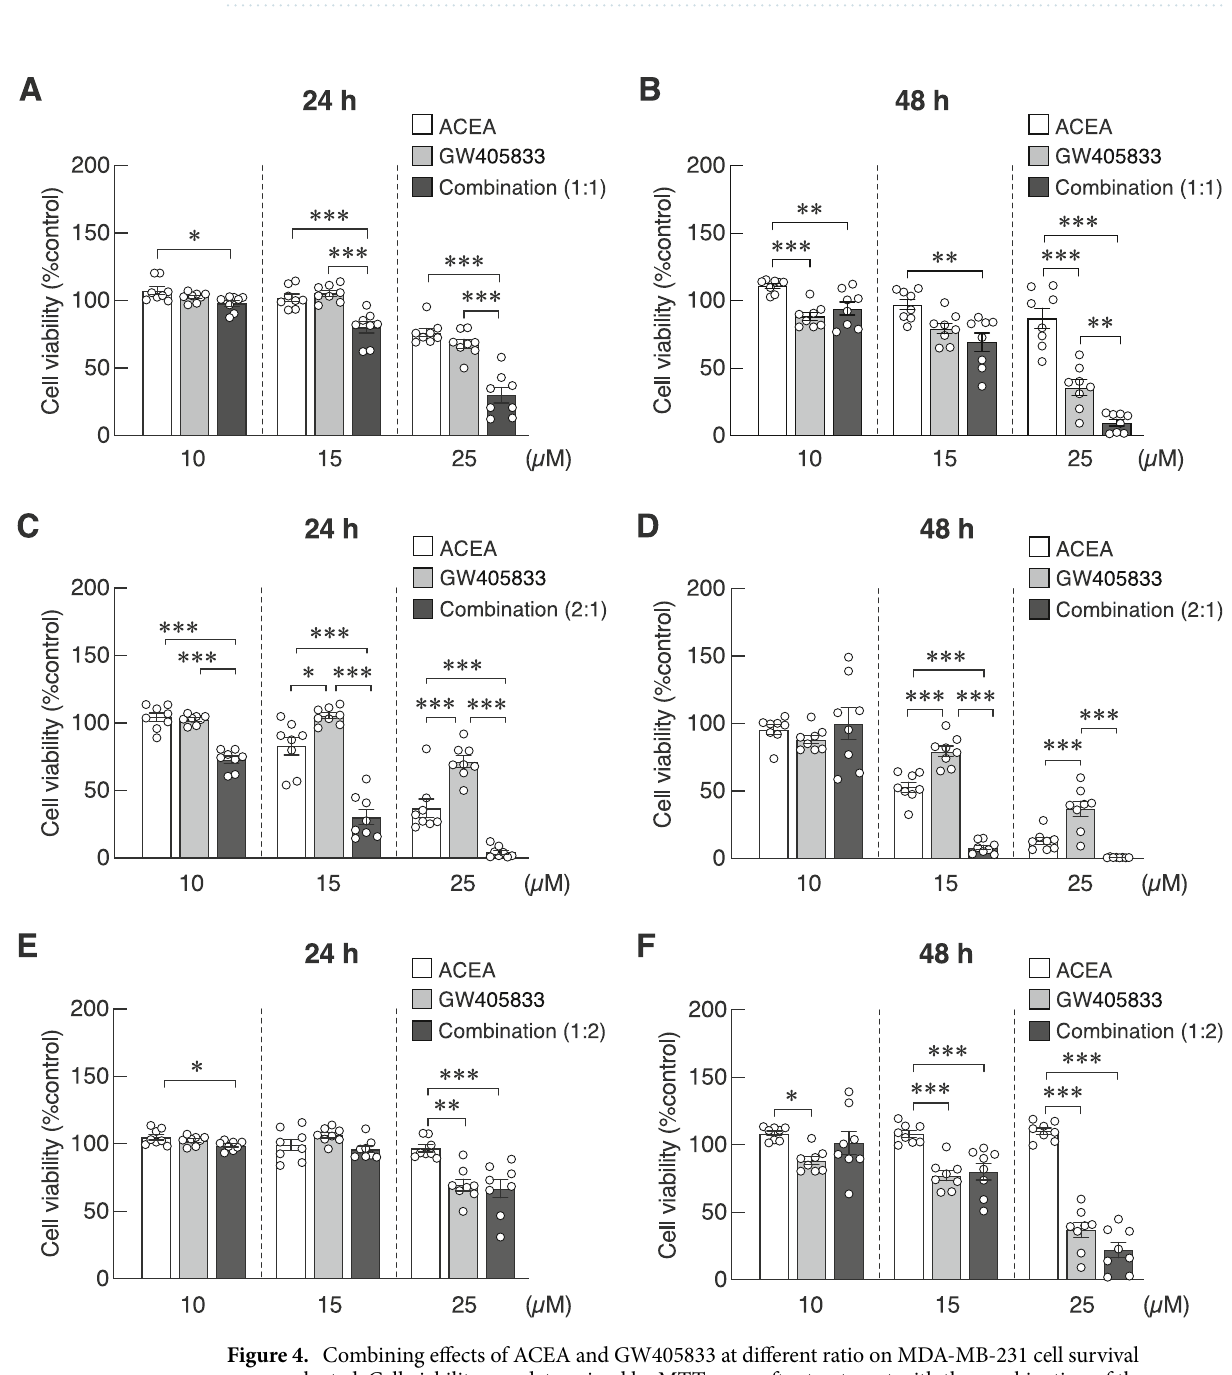
Figure 4. Combining effects of ACEA and GW405833 at different ratio on MDA-MB-231 cell survival were evaluated. Cell viability was determined by MTT assay after treatment with the combination of these compounds at different ratio (ACEA:GW405833) of 1:1 ( a , b ), 2:1 ( c , d ) or 1:2 ( e , f ) for 24 and 48 h. Bars represent mean ± SEM of four independent biological replicates with two technical replicates each. (*** p < 0.001, ** p < 0.01, * p <